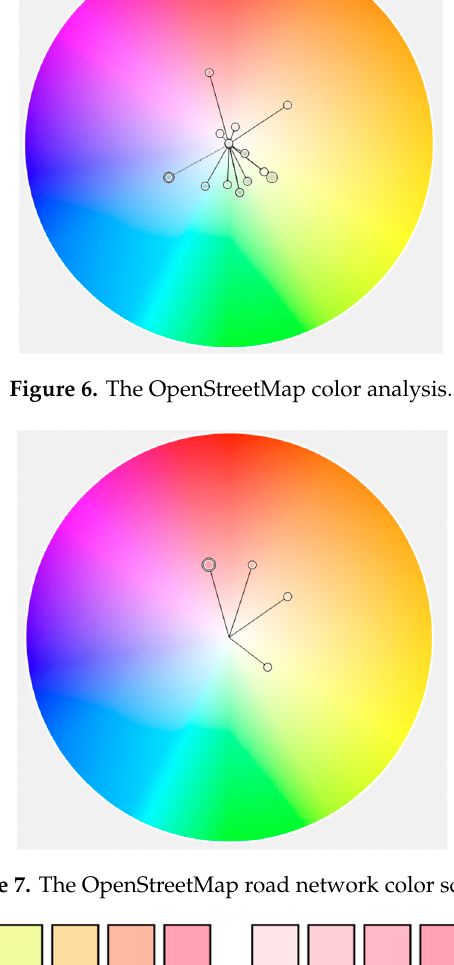
Figure 8. The OpenStreetMap road network symbols color scheme (left) and suggestions: ( a ) for analogous color scheme; ( b ) and ( c ) alternatives for monochromatic color schemes.